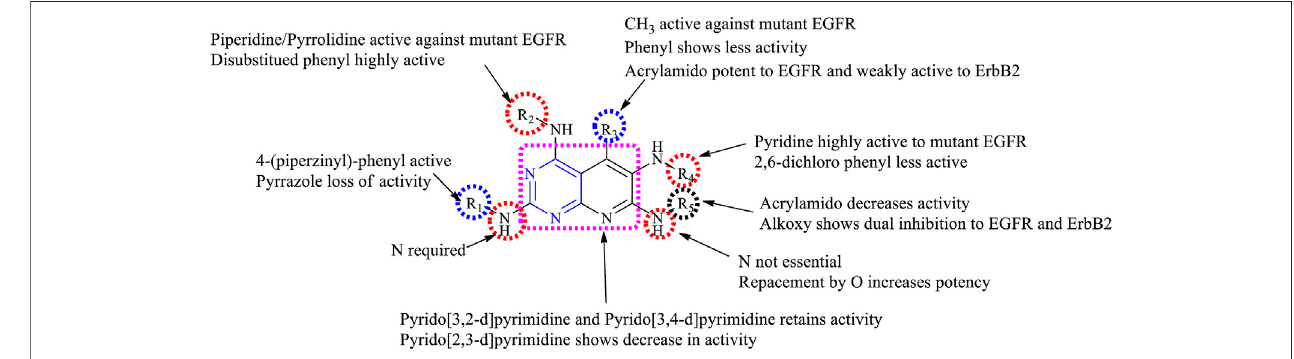
FIGURE 7 | Summary SAR of trisubstituted pyridopyrimidine.